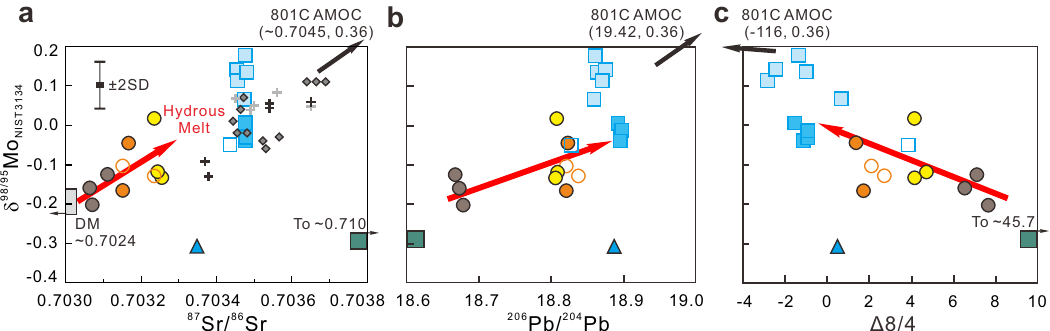
Fig. 6 Mo, Sr, and Pb isotopes of Pagan and NW Rota-1 volcanic rocks. Plots of a δ 98/95 Mo vs. 87 Sr/ 86 Sr, b δ 98/95 Mo vs. 206 Pb/ 204 Pb and c δ 98/95 Mo vs. Δ 8/4 for the Pagan and NW Rota-1 samples unaffected by amphibole fractional crystallization. Δ 8/4 is the displacement from the Northern Hemisphere Reference Line in 208 Pb/ 204 Pb – 206 Pb/ 204 Pb space 74 . The Sr-Mo isotopes of the depleted mantle (DM) are estimated according to the study on Paci fi c – Antarctic ridge basalts 34 . The Izu, other Mariana volcanic front, and average Mariana sediments data are also plotted for comparison. The ranges for the average 801 C AMOC 5,8,52 run off of the diagrams. The symbols and data source are as in Fig. 3. SD standard deviation, AMOC altered ma fi c oceanic crust.